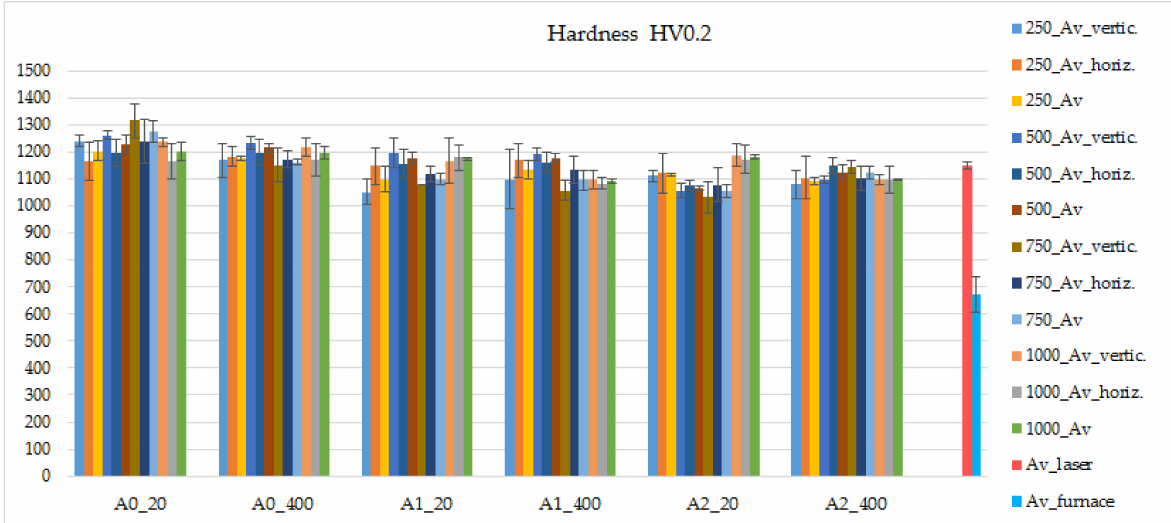
Figure 12. Average hardness HV0.2 of the coating remelted at different parameters: Av_horiz.— average hardness calculated from the horizontal hardness distribution values; Av_vertic.—average hardness calculated from the vertical (depth) hardness distribution values; Av—the mean of Av_horiz. And Av_vertic.; Av_laser—the mean of all Av values; 250, 500, 750, 1000—indicates laser speed; 20 and 400—preheating temperature; A0, A1, and A2—0 mm, 1 mm, and 2 mm oscillation amplitude.